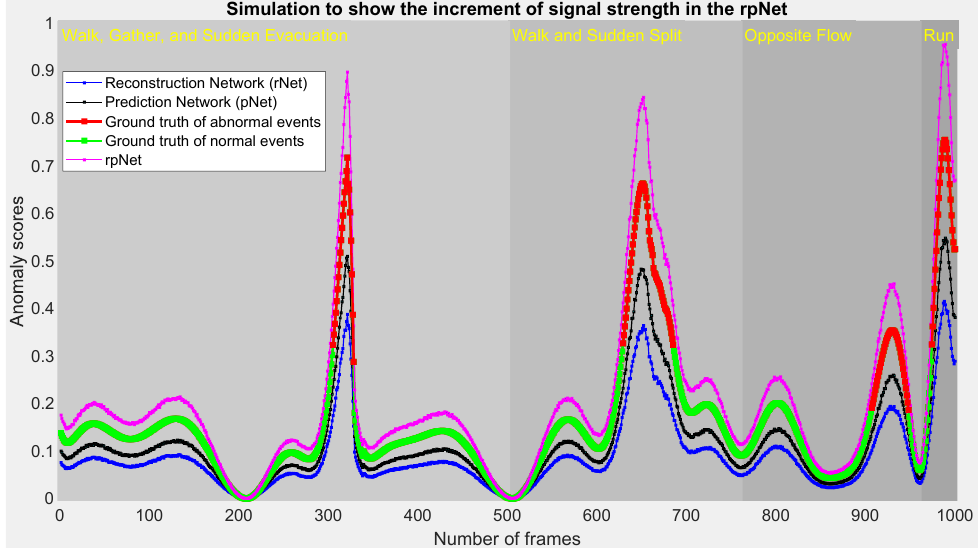
Figure 11. Simple simulation to show that the rpNet can guarantee larger error gap.